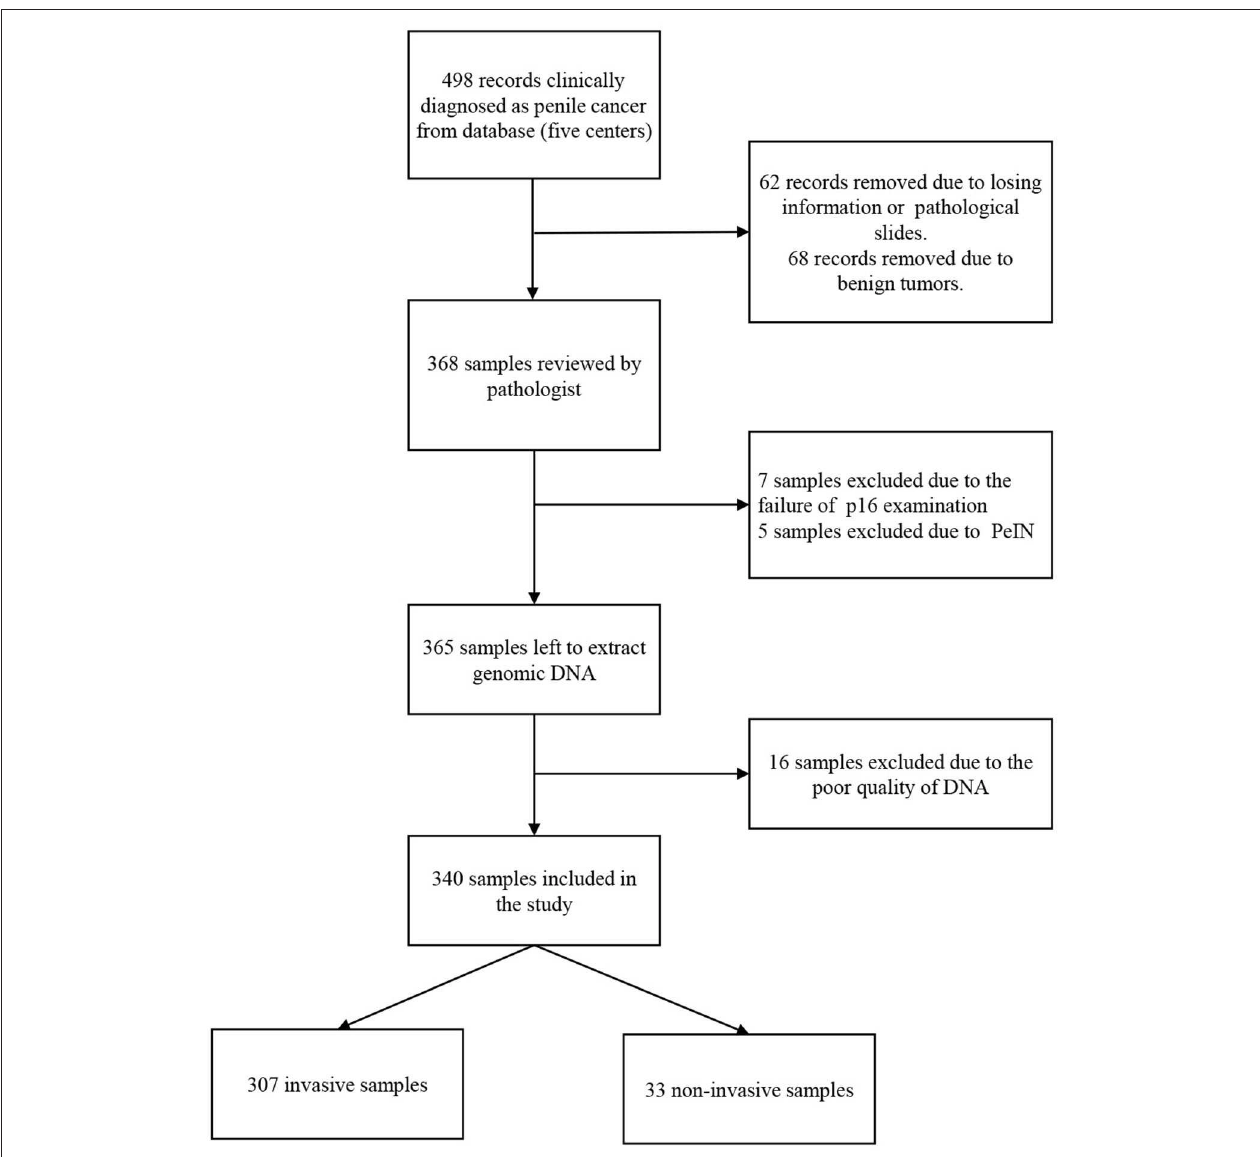
FIGURE 1 | Flow diagram of patient identification and